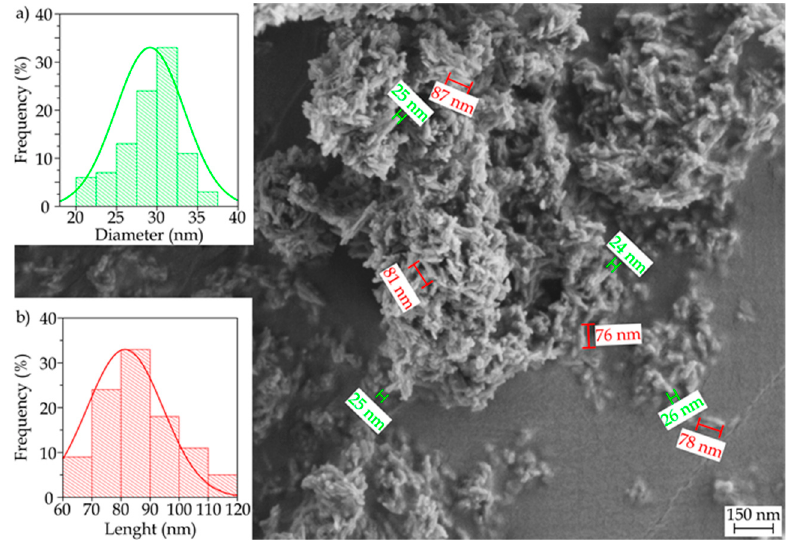
Figure 7. Field-emission scanning electron microscopy (FESEM) images of the hydroxyapatite nanoparticles (nHA) powder. Image was taken at 10,000× with scale marker 150 nm. Micrographs obtained by FESEM of the fracture surfaces of the injection-molded parts of P(3HB- co -3HHx) and the various P(3HB- co -3HHx)/nHA composites after the Charpy impact tests are